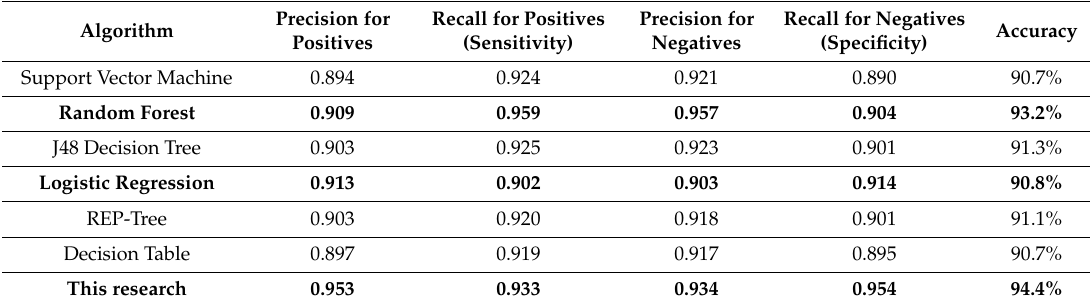
Table 6. Comparison of the results of our method with those of Ho-Quang et al.